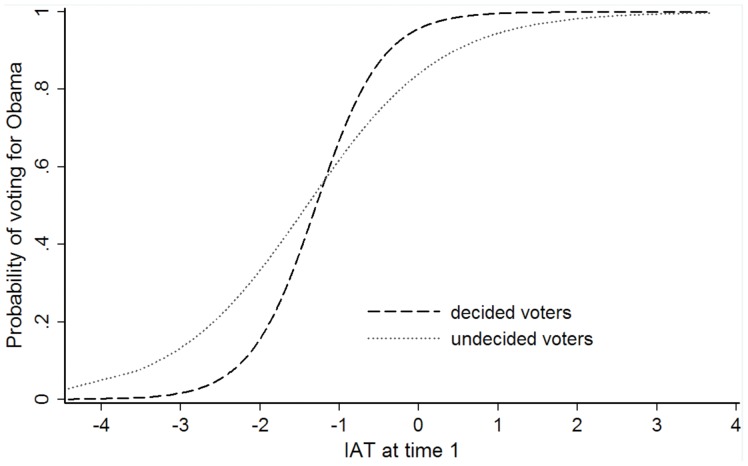
Probability of voting for Obama (vs. McCain).Probability of voting for Obama (vs. McCain) as a function of IAT, decidedness, and their interaction at time 1. High values indicate stronger implicit preferences for Obama (relative to McCain), and a higher probability of voting for Obama (vs. McCain). The IAT predicted the dichotomous choice of vote better for decided as compared to undecided voters as indicated by the steeper line for decided as compared to undecided voters. This indicates that the region of unclear prediction on the basis of IAT-scores (abscissa) between voting for McCain (score on the ordinate of 0) and voting for Obama (score on the ordinate of 1) was smaller for decided than undecided voters, leading to more correctly predicted votes for decided than undecided individuals. IAT scores were z-standardized prior to the analysis.